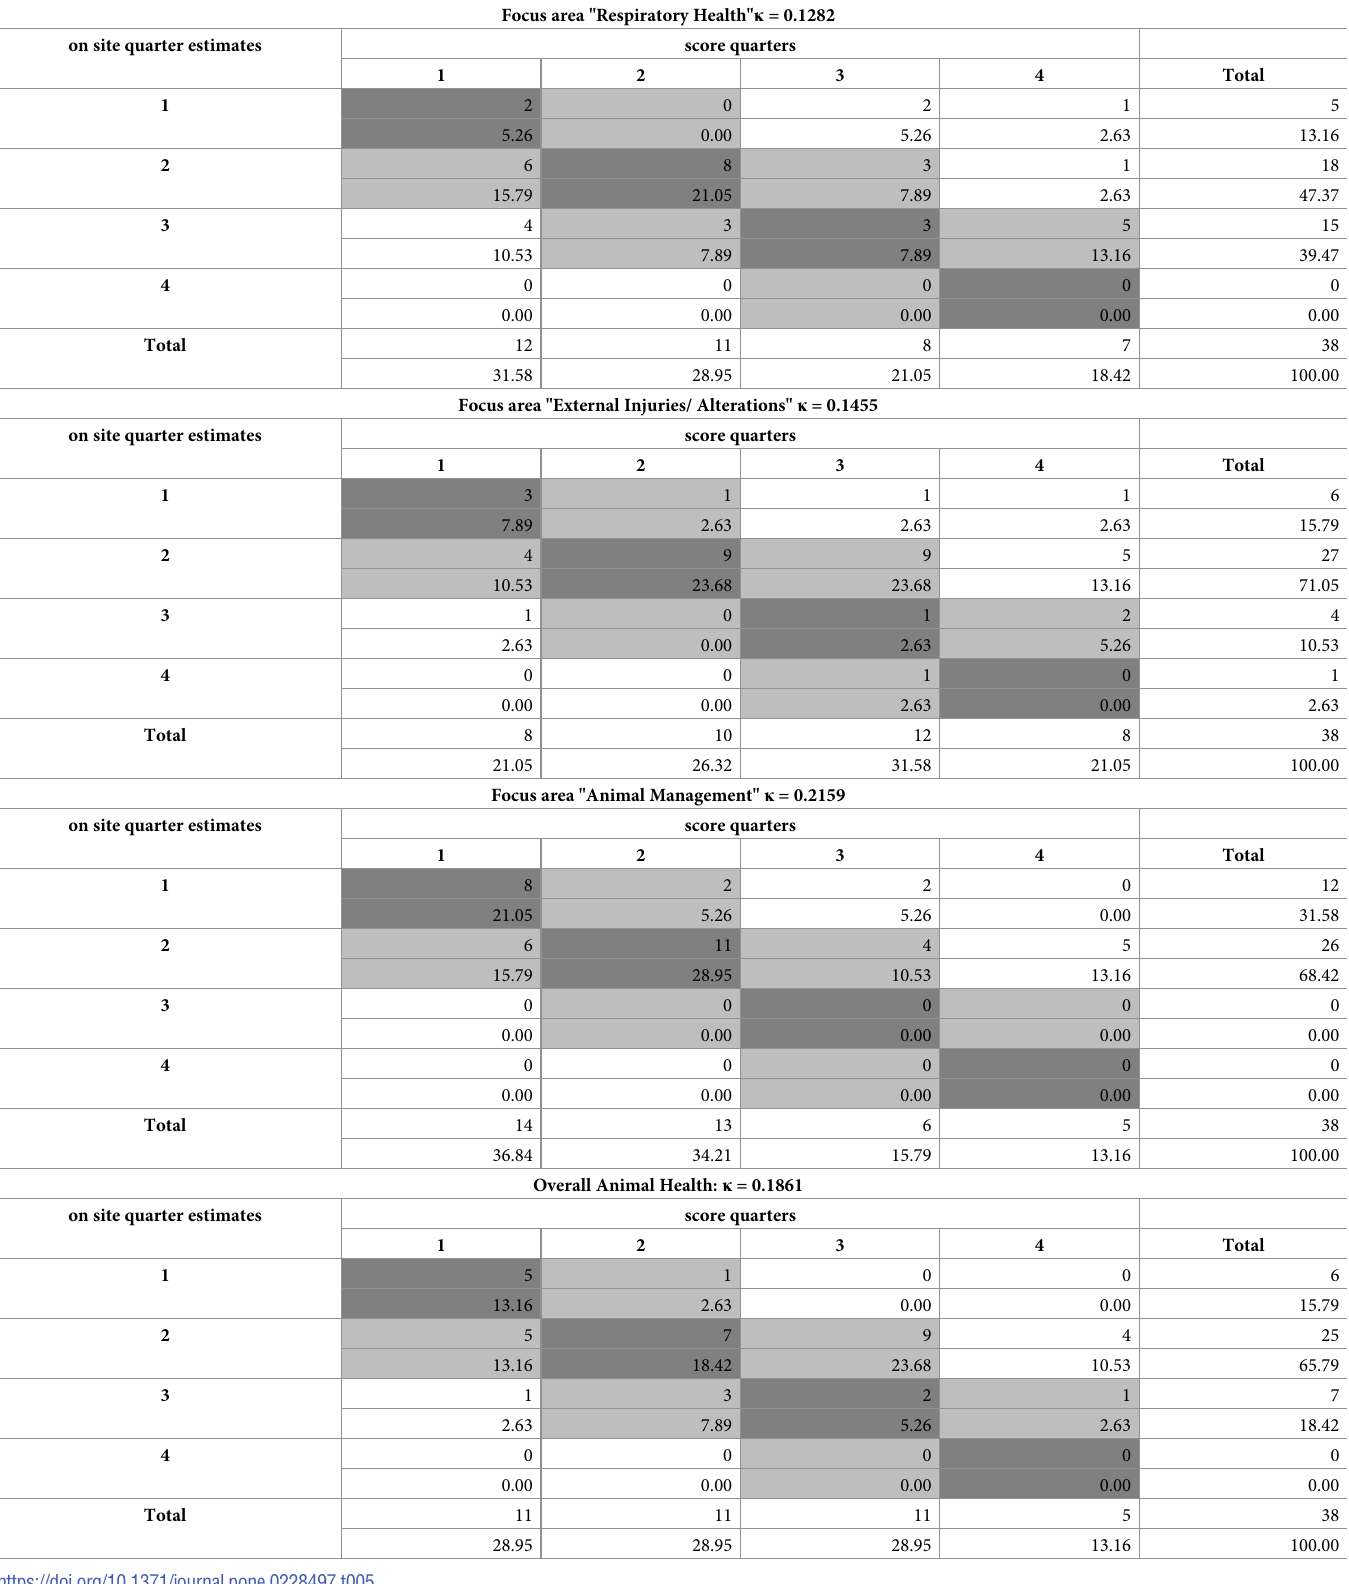
Table 5. Similarity tables contrasting scores with self-reported animal health (first number frequencies, second number percentages). Focus area "Respiratory Health" κ =